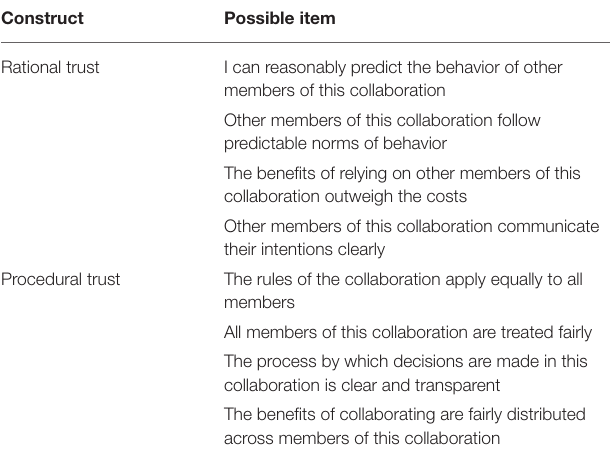
TABLE 2 | Measures of rational and procedural